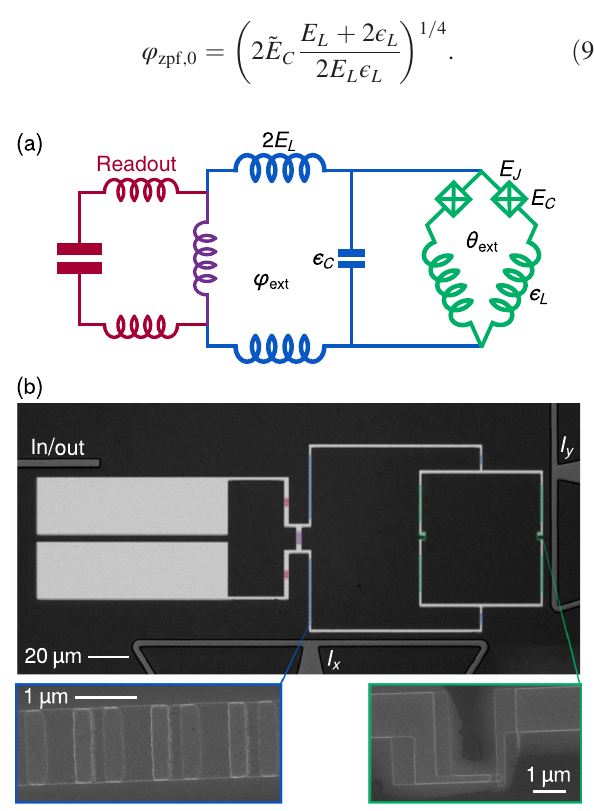
FIG. 3. Experimental implementation. (a) Extended electrical circuit diagram for the inductively shunted KITE including the lumped LC oscillator (maroon) added for dispersive readout, which couples inductively to the circuit through a shared inductance (purple). (b) Optical micrograph of the physical device, with aluminum electrodes in light gray and niobium electrodes in dark gray. Direct currents, microwave drives, and readout signals are routed in and out of the system through two on-chip flux bias lines (right and bottom) and one weakly coupled pin (top left). Insets: scanning electron microscope images of one array of large junctions [all inductances pictured in (a) are implemented similarly] and one small junction.